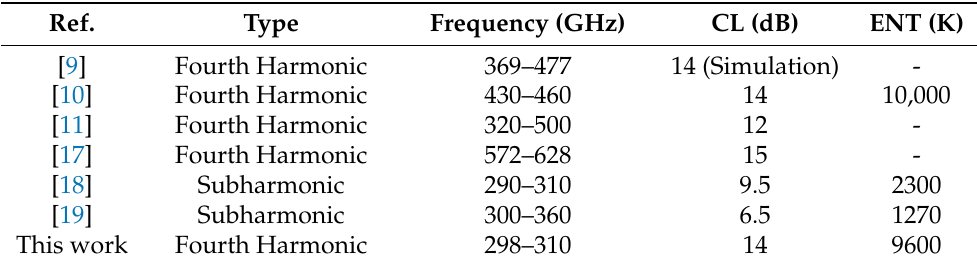
Table 1. State-of-the-art of fourth-harmonic Schottky diode mixers working at frequencies similar to this